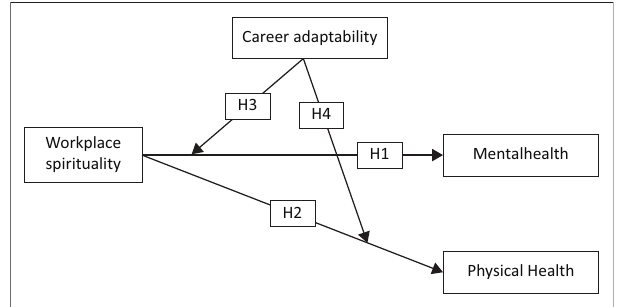
FIGURE 1: Conceptual